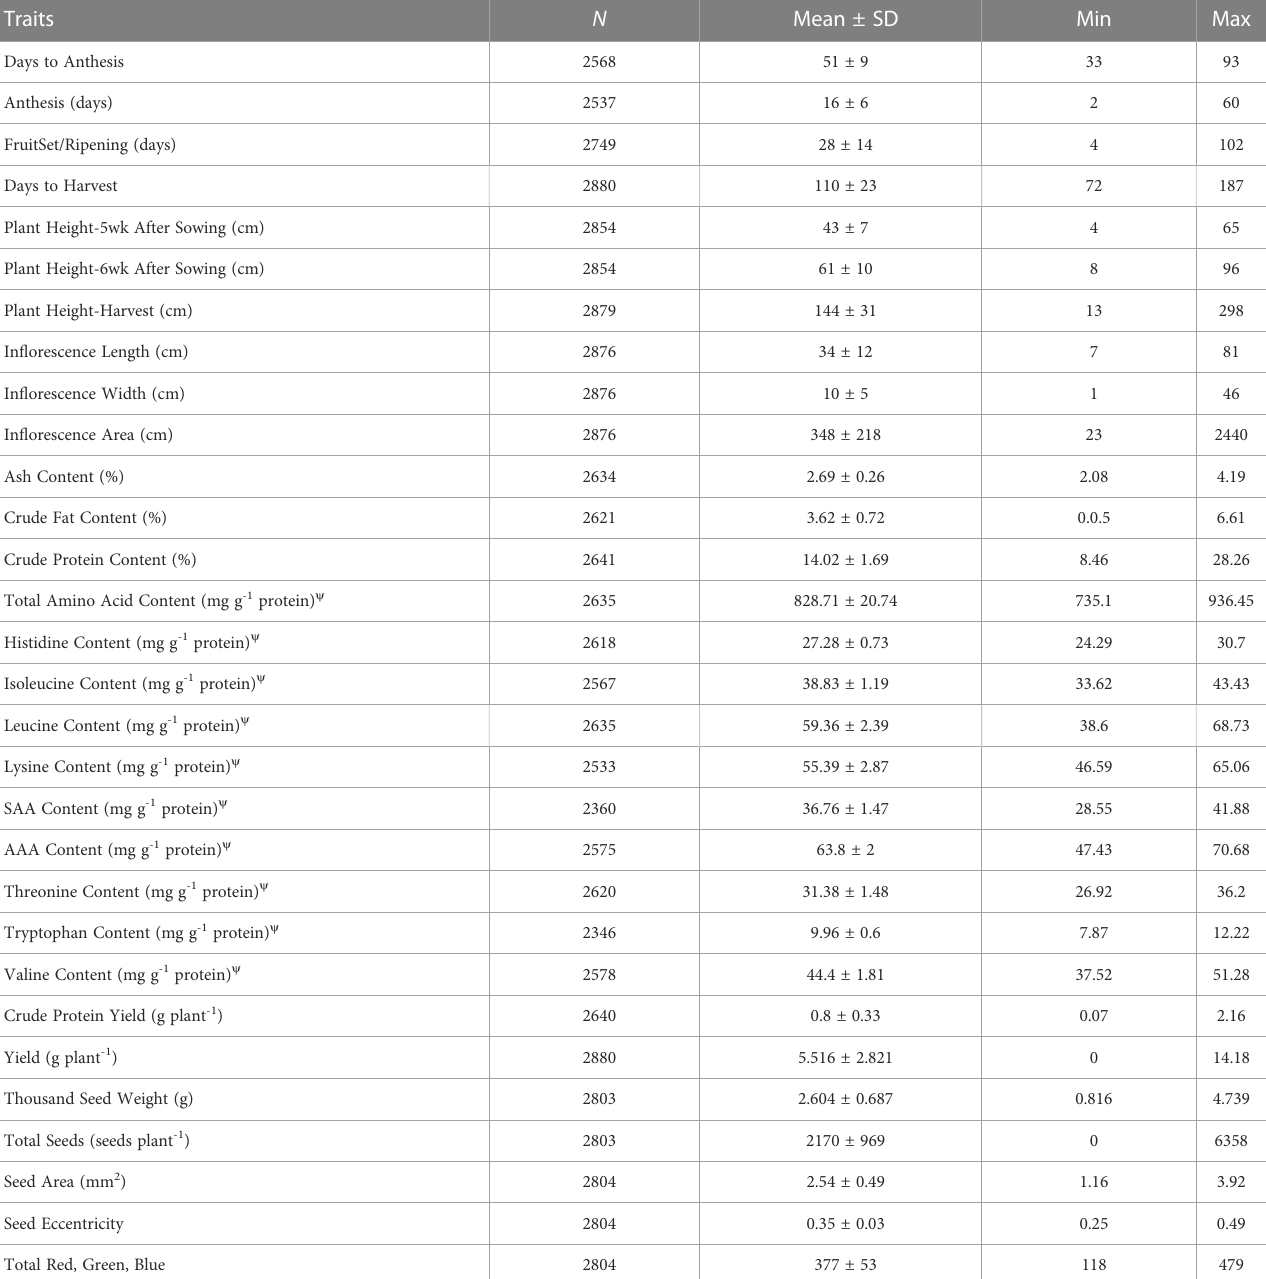
TABLE 3 Summary statistics provided for the traits studied, including the total number of data points ( N ), standard deviation (SD), minimum (min), and maximum (max).